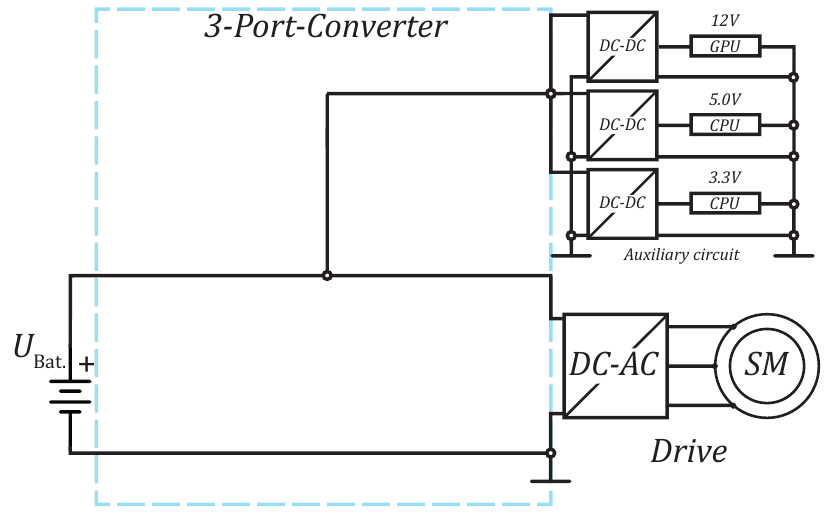
Figure 5. Topology I: Auxiliary circuits and drives are connected directly to the battery. The bus voltage is equal to the battery voltage which depends on the state of